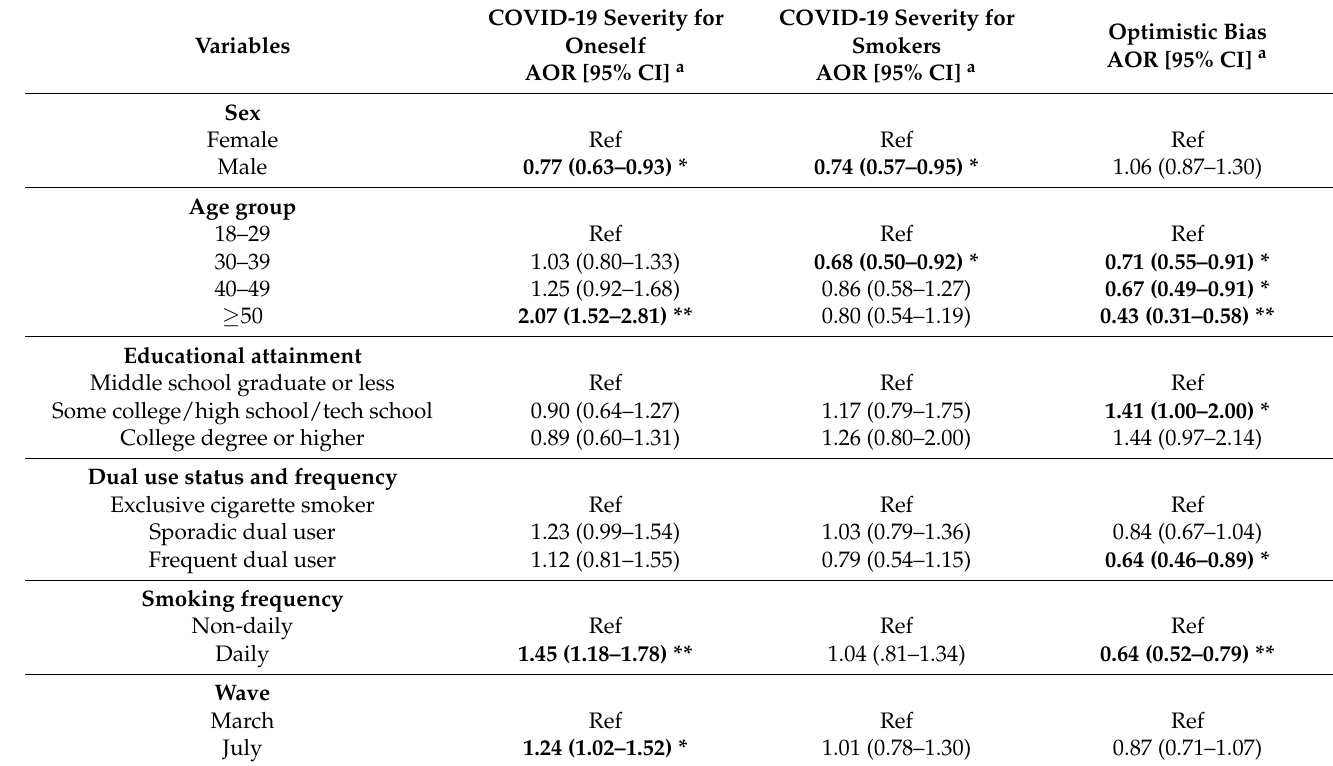
Table 5. Independent correlates of COVID-19 severity variables among Mexican adult smokers (Sample B,